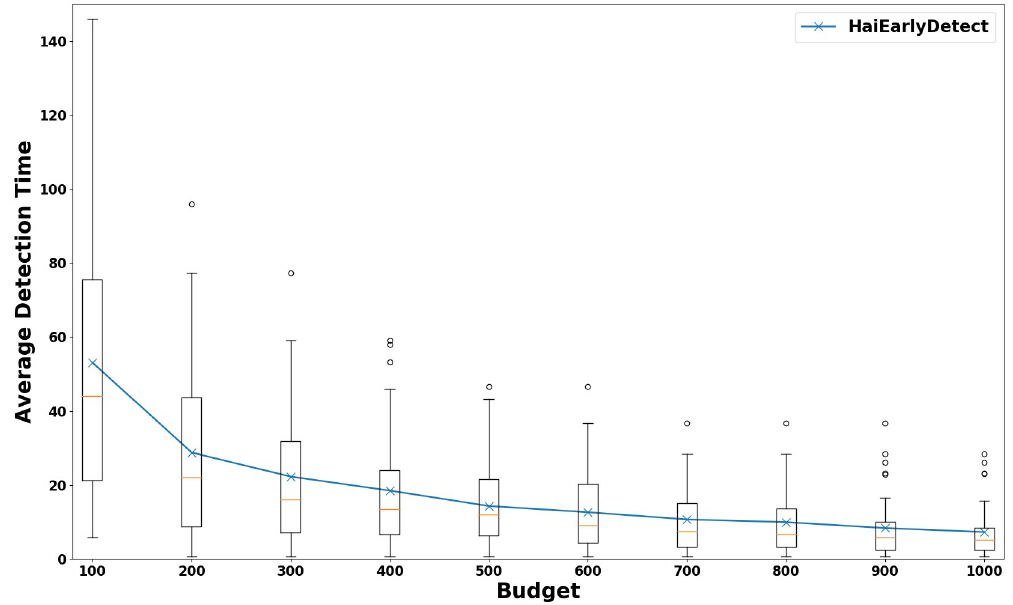
Fig 10. Variation in detection time (in days) for various budgets. As budget increases, the variation